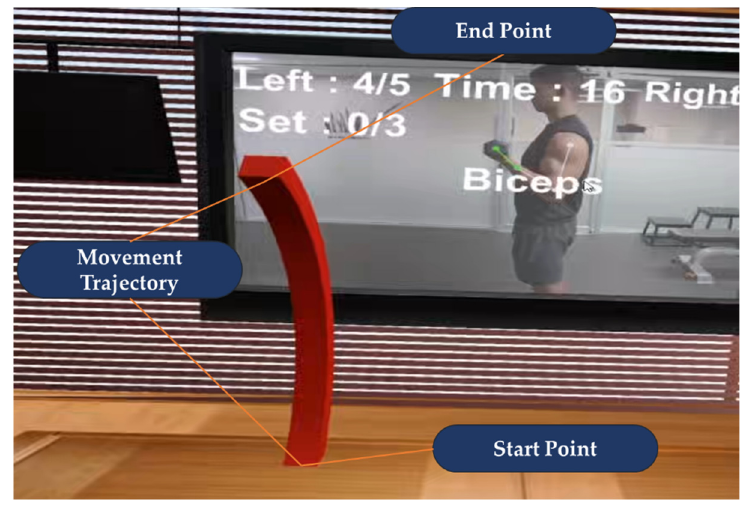
Figure 5. Customized movement trajectory in terms of a dumbbell curl process.